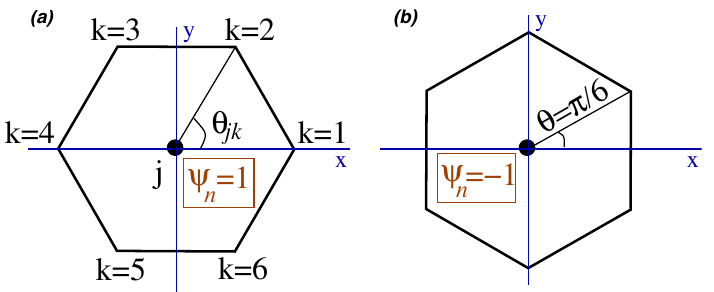
Figure 1. Cell-orientation order parameter (Eq. 2). The angle θ jk is measured from an arbitrarily chosen x-axis through the centre as shown in ( a ). For a regular hexagon with inner angles at 2 π/ 3 , the orientation in ( a ) has ψ n = 1 while in ( b ) ψ n = − 1 . In general, ψ n is orientation-dependent with | ψ n | less than or equal to 1. For regular hexagons, individual ψ n lies on the unit circle. The six-fold symmetry of a regular hexagon is preserved by ψ n as it returns to its value under a π/ 3 rotation of the hexagon around its